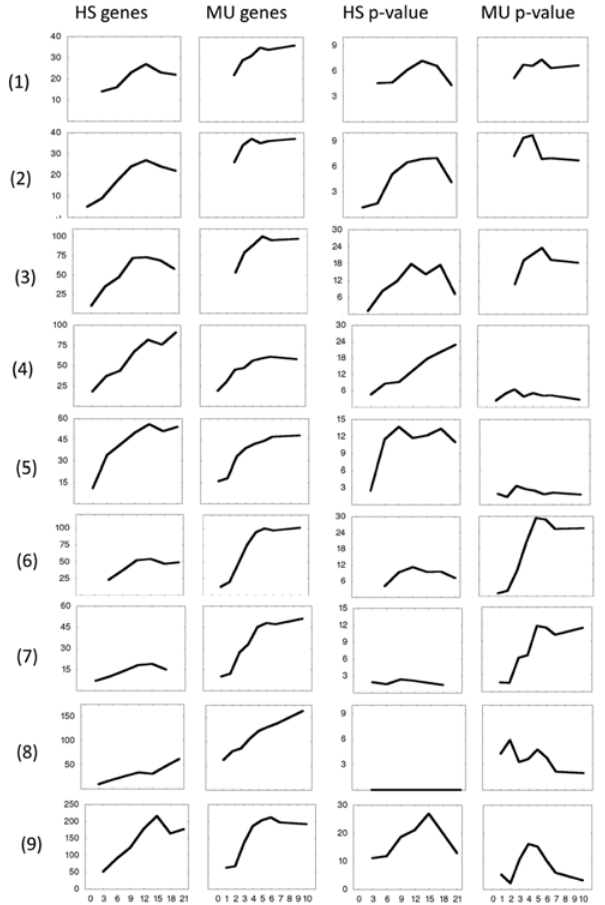
Fig 1. Number of upregulated (compared to day 0) genes and enrichment p-values for several organ development categories and TFs. Gene numbers (left two columns) and enrichment p-values (-log 10 (p), right two columns) for up-regulated genes of GO Biological Processes: (1) kidney development, (2) lung development, (3) skeletal system development, (4) neuron development, (5) sensory organ development, (6) vascular development, (7) muscle tissue development. Notation MU stands for mESC and HS for hESC data. (8) Down- and (9) upregulated genes, annotated as transcription